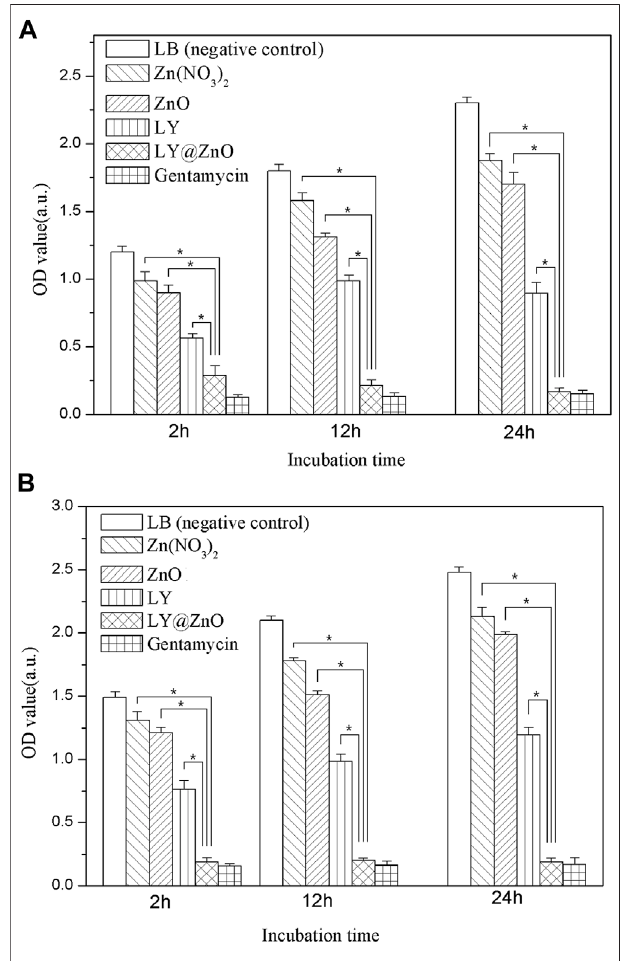
FIGURE5| ODvaluesofantibacterialactivityfor fi veantibacterialagents with the concentration of 20.0 mg/L observed to against bacteria. (A) E. coli ; (B) S. aureus